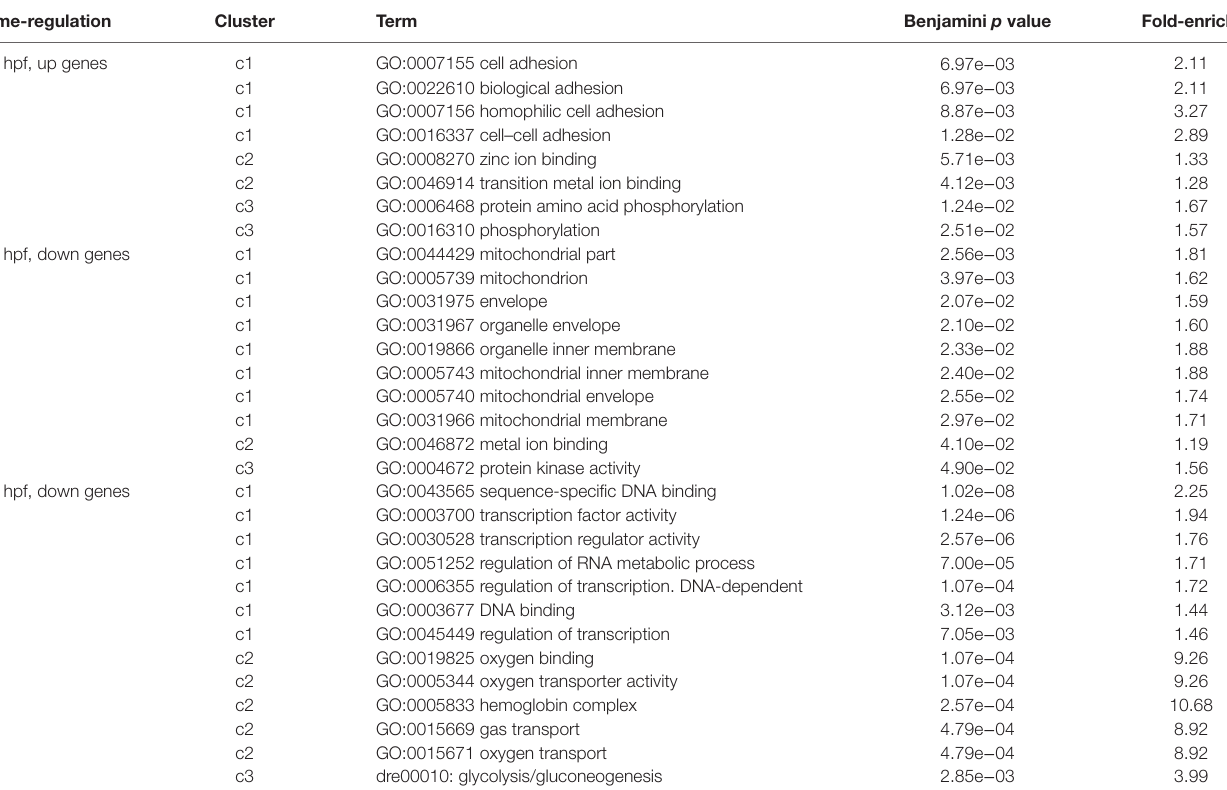
Table 2 | Most significant categories from functional annotation clustering analysis of the deregulated transcripts were reported. Time-regulation cluster Term benjamini p value